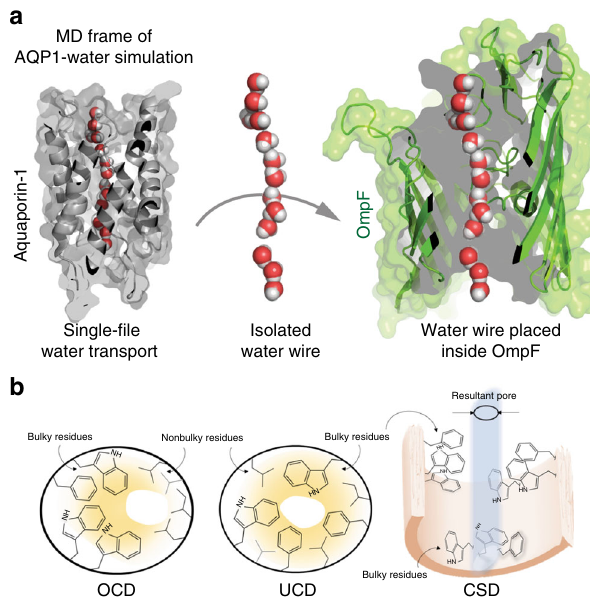
Fig. 1 Water wire from Aquaporin 1 (AQP1) was used as a template to redesign OmpF pore geometry. a The left panel shows a frame from an MD simulation of single- fi le water permeation through AQP1. The pore wall residues capable of forming hydrogen bonds with the permeating water wire have been highlighted in yellow. The water wire is isolated with its geometry preserved and is thereafter placed in the OmpF pore. The pore- constricting residues are altered such that they fi ll up the space around the water wire forming a molecular mold of the selective internal geometry of AQP1 within OmpF beta scaffold. b The three distinct internal pore geometries of OmpF that resulted from the employed redesign procedure included: (i) off-center pore closure design (OCD), (ii) uniform pore closure design (UCD), and (iii) cork-screw design